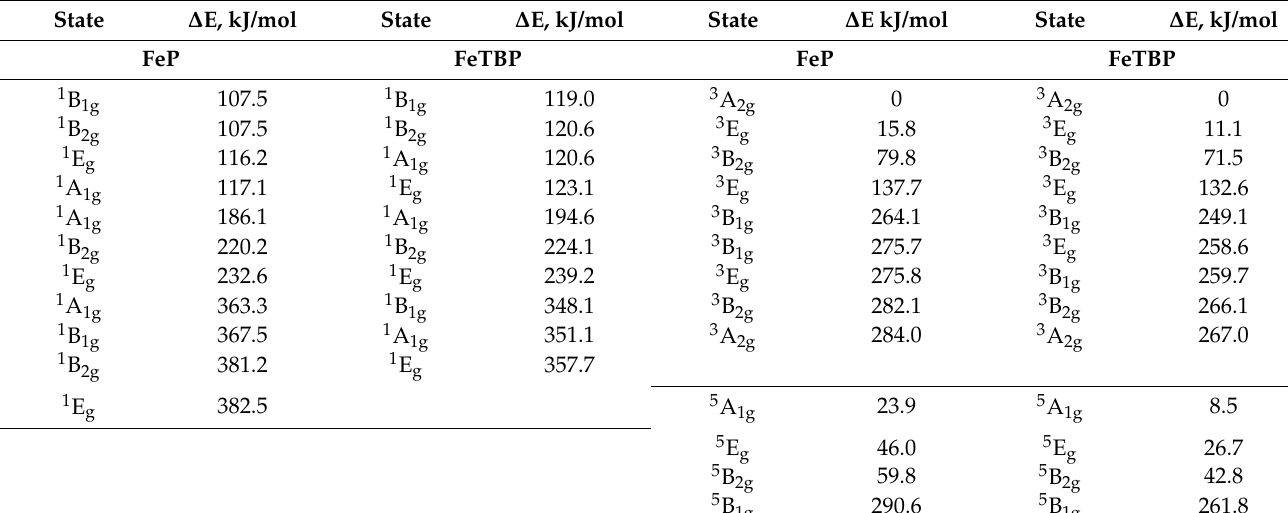
Table 1. The relative energies (kJ/mol) of excited states from MCQDPT2 calculations.